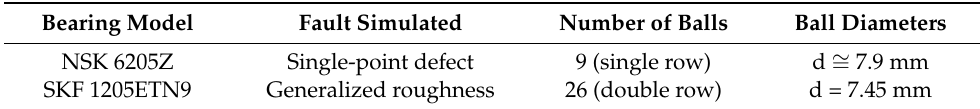
Table 2. Main characteristics of the bearings